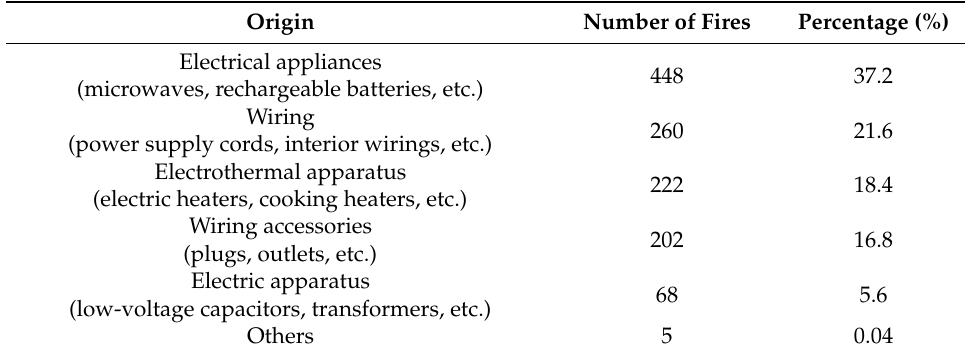
Figure 1. Major causes of fire accidents within the jurisdiction of Tokyo Fire Department in Japan from 2014 to 2018 [1]. Table 1. Origin of fires from electrical equipment [1].